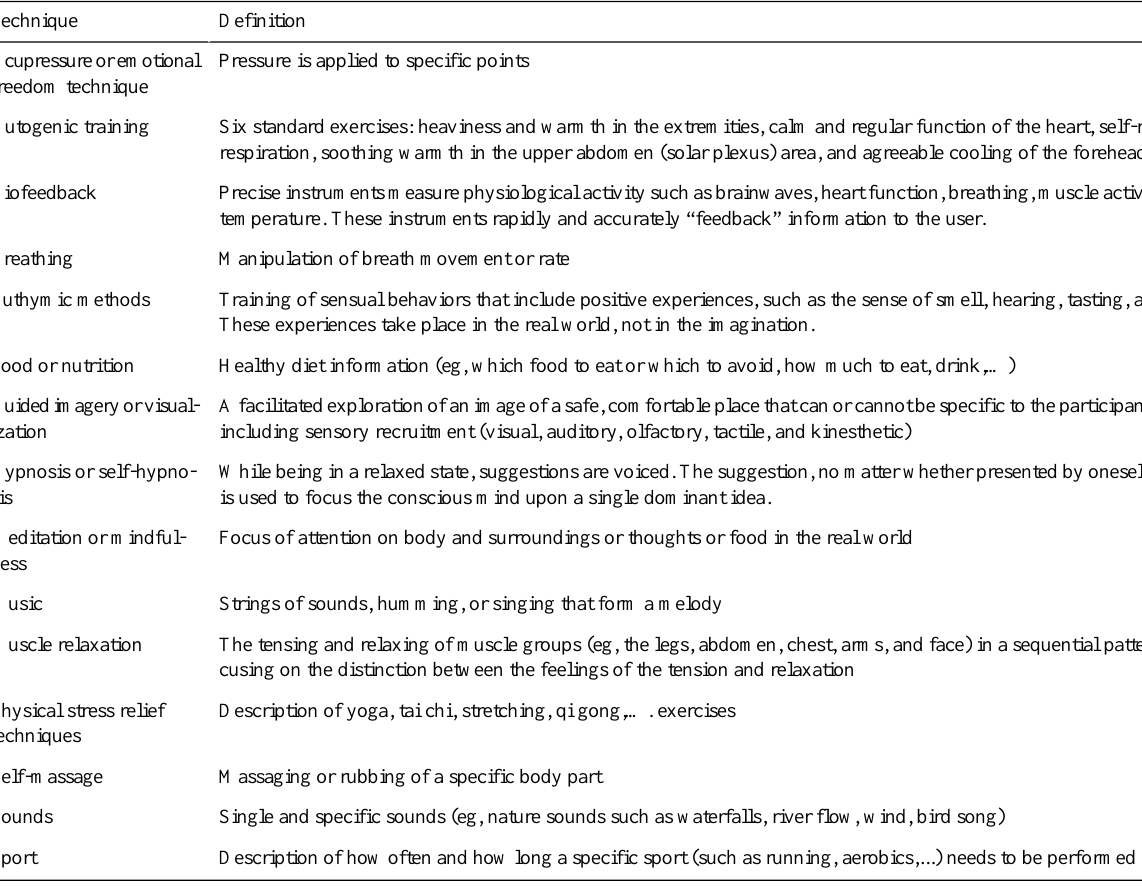
Table 1. Effective emotion-focused relaxation